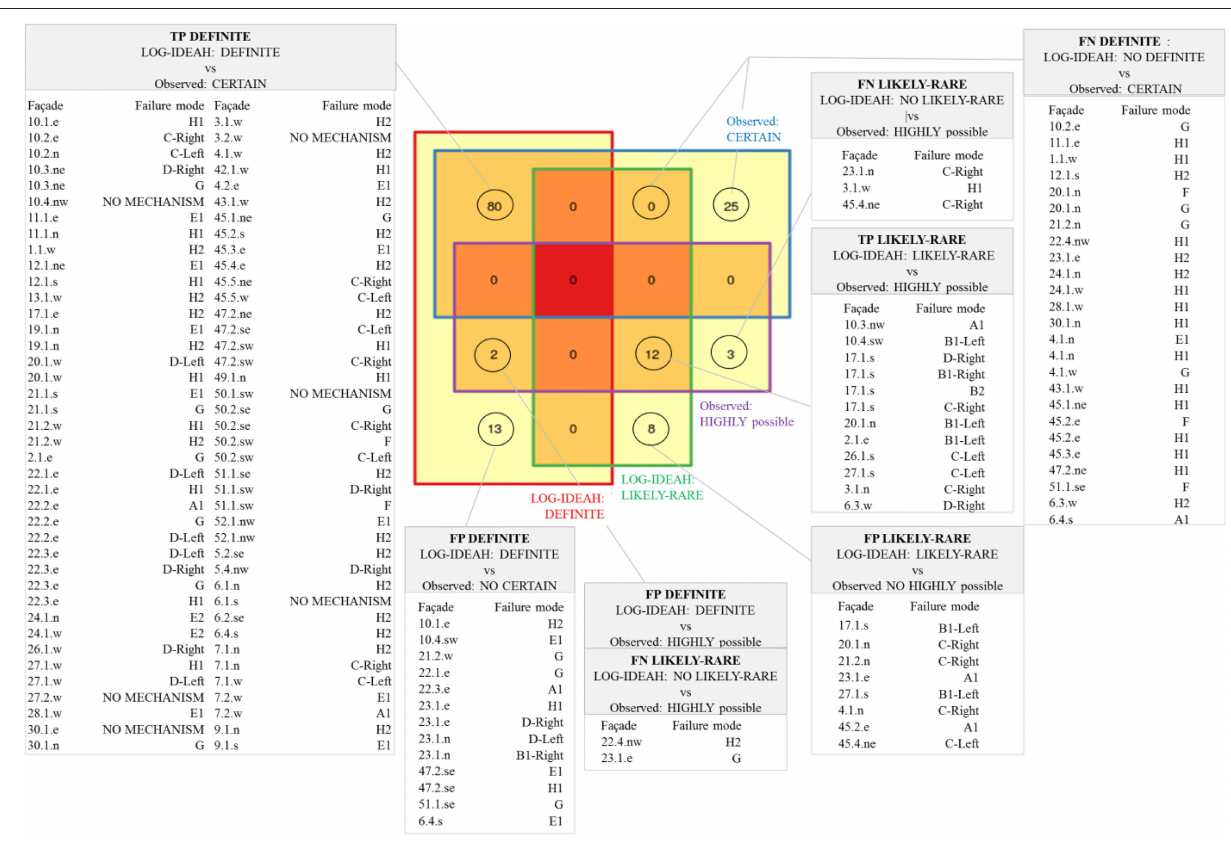
FIGURE 14 | Venn diagram. Identification of TP (True Positive), FP (False Positive), and FN (False Negative) for data set DEFINITE and LIKELY-RARE. “Façade” is list of the names associated to each inspected façade, and “Failure mode” is list of the failure modes detected by LOG-IDEAH for each data set and all their possible relations with the failure modes observed on site by trained